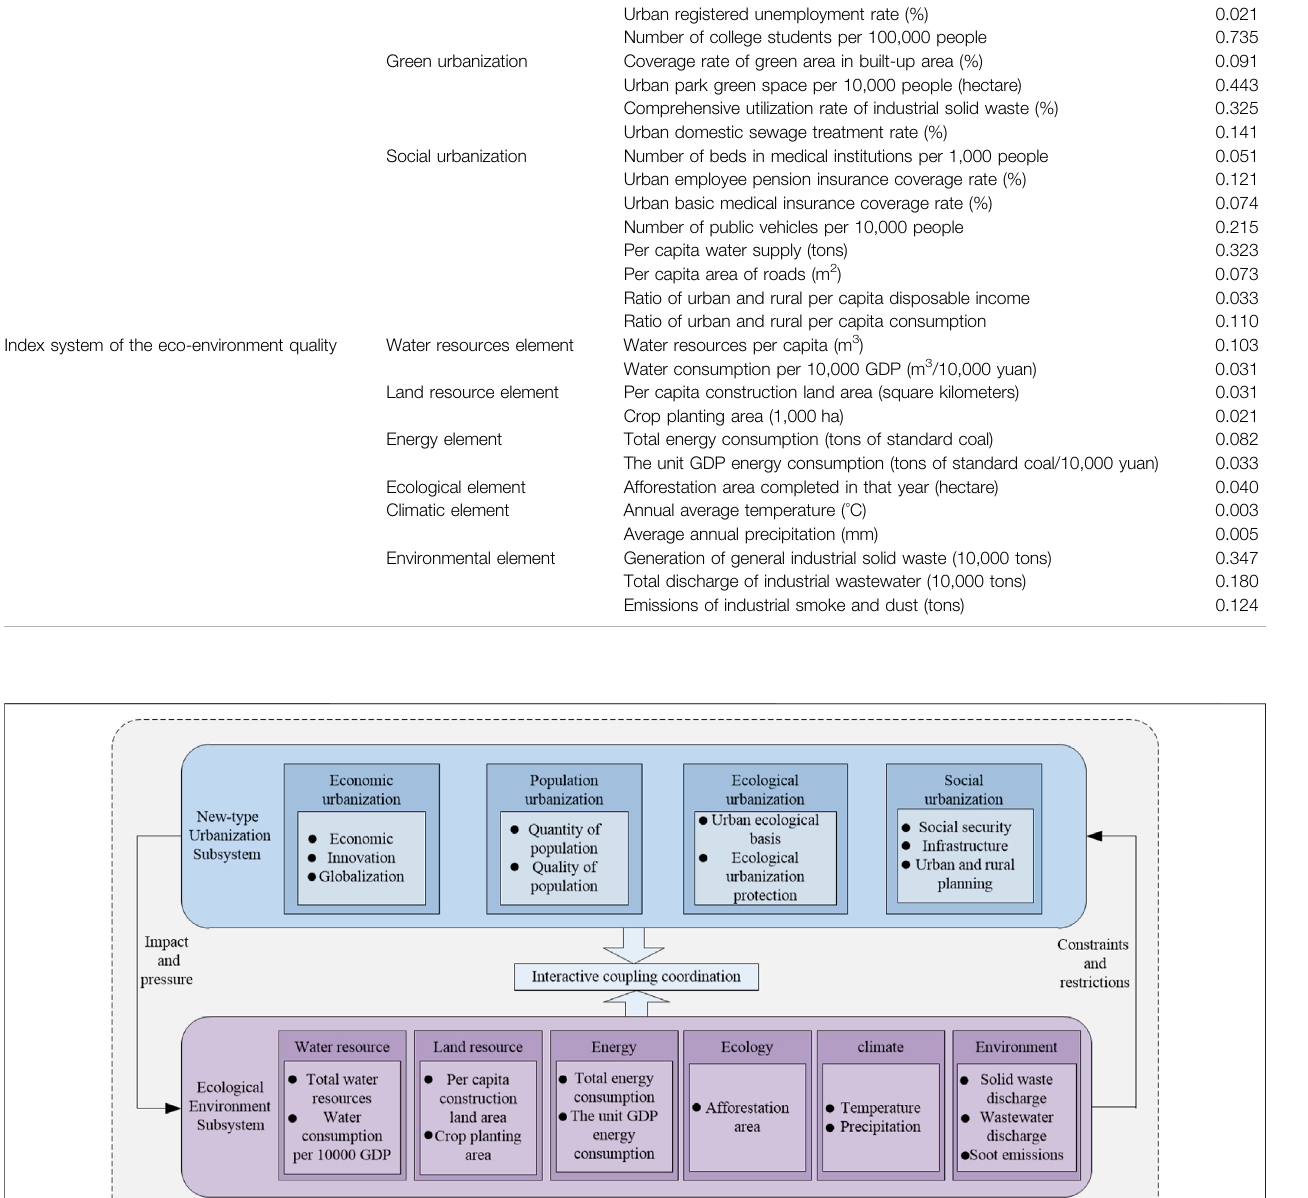
Frontiers in Environmental Science |